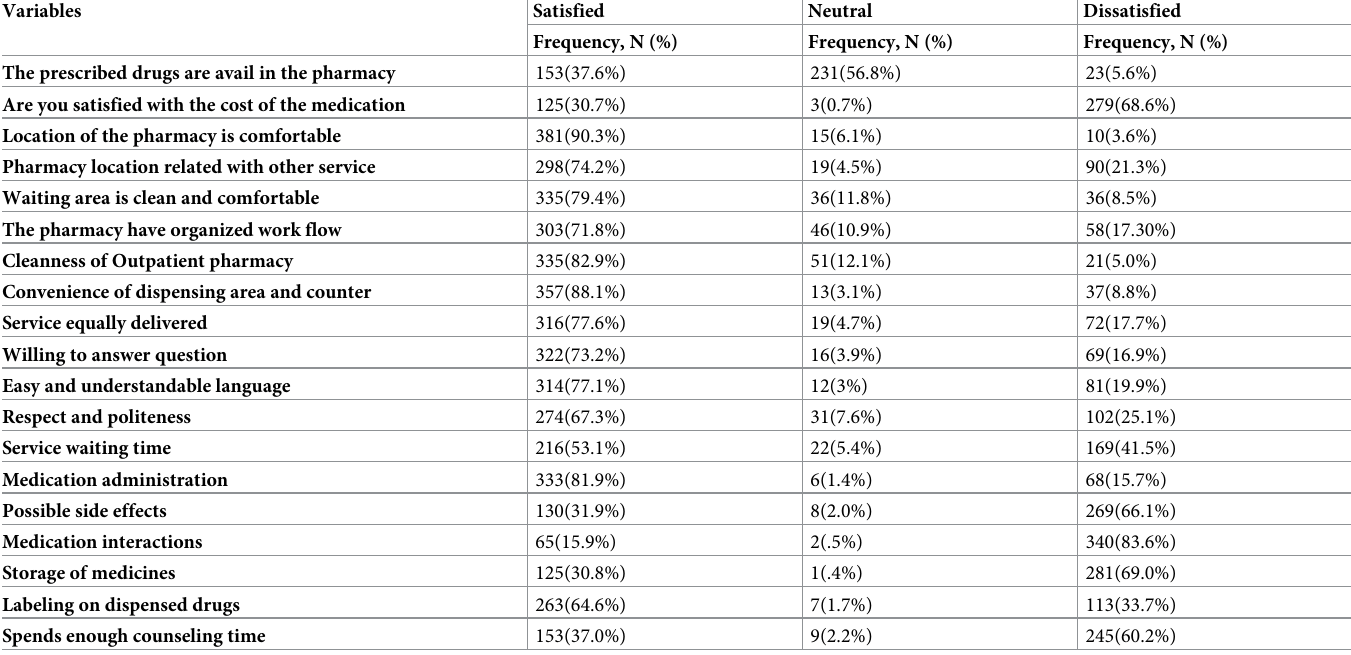
Table 2. The satisfaction status of clients at Dubti General Hospital, Afar, Ethiopia, 2020.